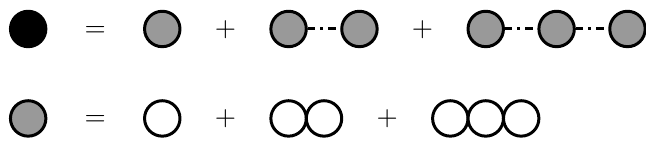
Figure 6 . Diagrams defining the solid black bubble as a sum of infinite diagrams involving partially- dressed bubbles which are drawn as gray bubbles. The gray bubble is in turn defined as a chain of bubbles as shown in the second line of the